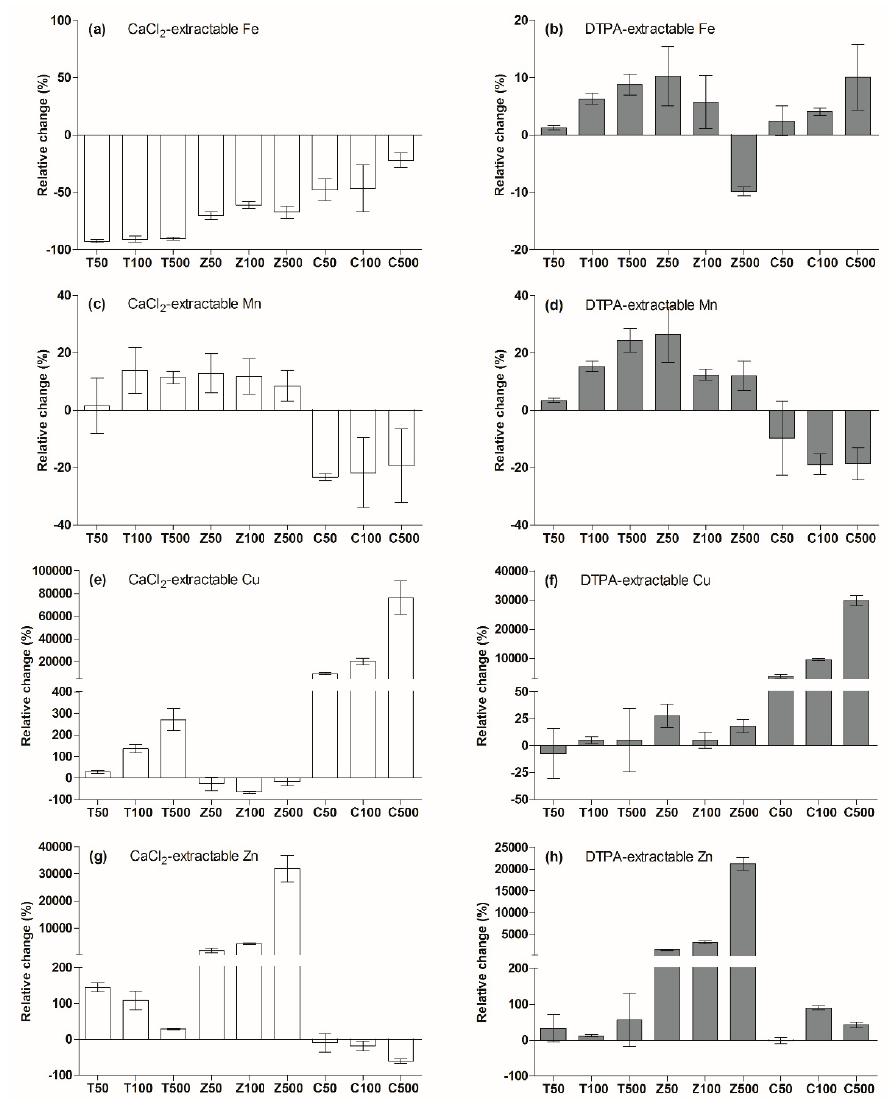
Figure 6. Relative change in soil micronutrient bioavailability after the addition of nanoparticles.